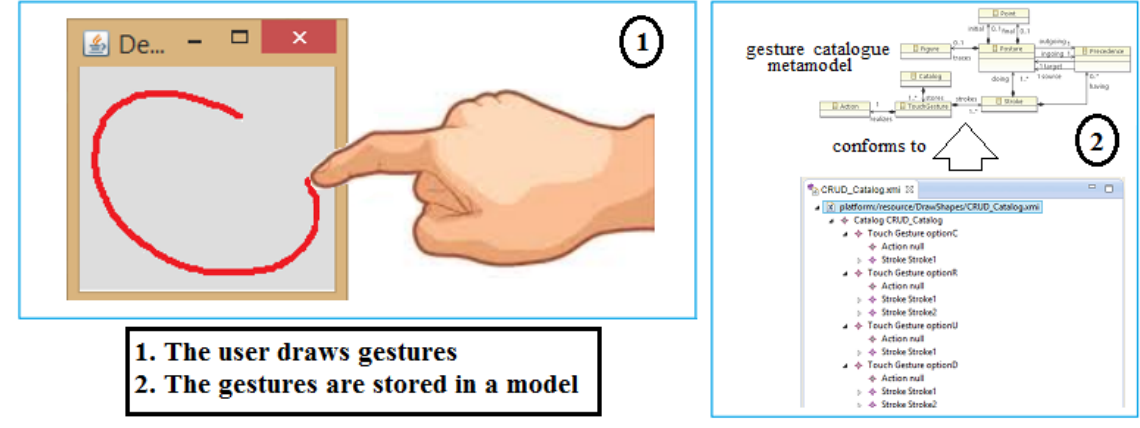
Figure 8. Platform-independent gesture catalogue definition